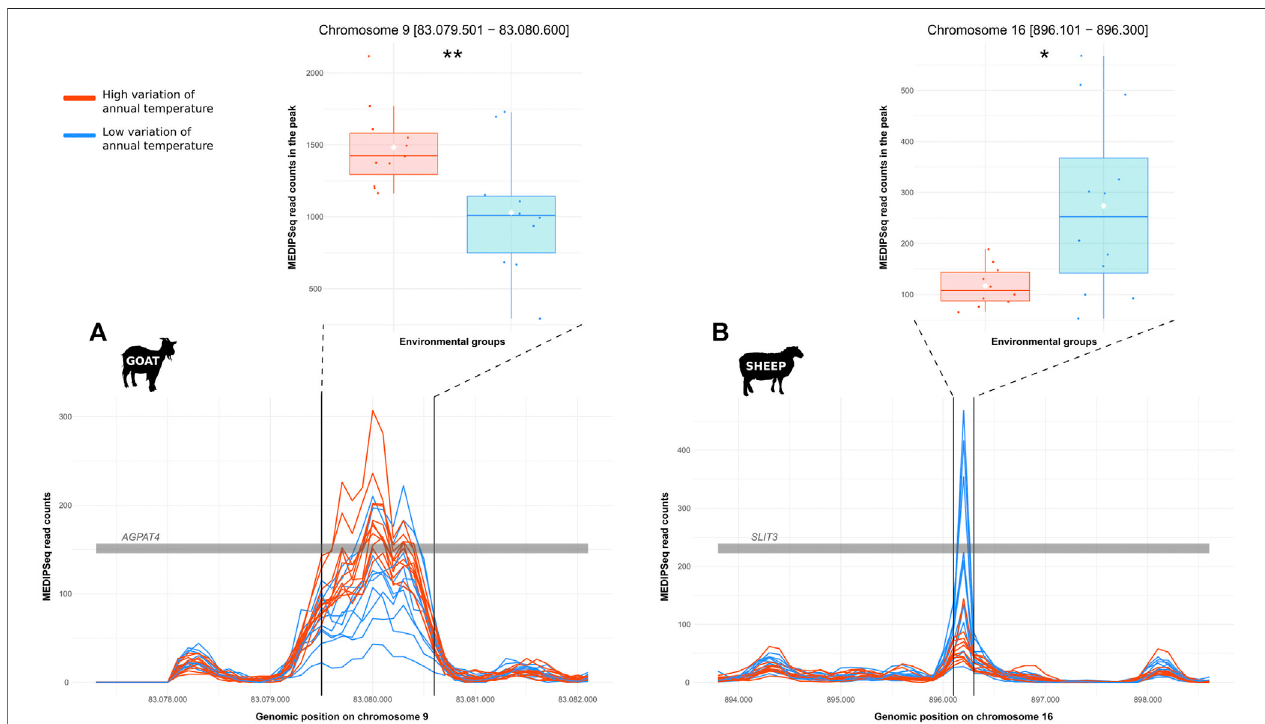
FIGURE 4 | Differentially methylated regions putatively involved in temperature acclimation in small ruminants. DMRs between genomes from locations with low (blue) and high (red) temperature annual range for (A) . goat or (B) . sheep. Each line represents the variations of the level of DNA methylation along a gene for one individual;thegreybarrepresentspartofthegene;thetwoblacklinesdelineatethepeakonwhichthedifferentiallevelofmethylationwastested.Boxplotsrepresentthe level of methylation (MeDIP-Seq coverage) for each group compared with a Wilcoxon test (Signi fi cance codes: ** (cid:1) p -value ≤ 0.01, * (cid:1) p -value ≤